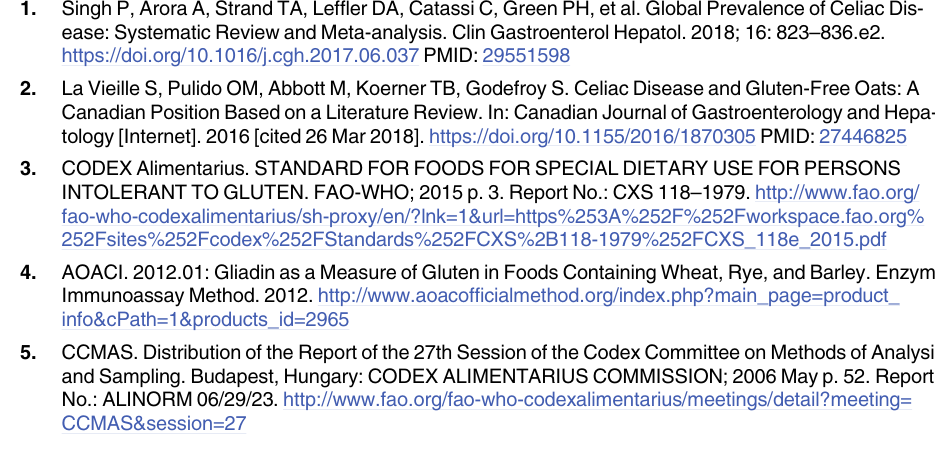
S1 Table. Consensus sequences obtained from multiple alignments sequences (MSA) and